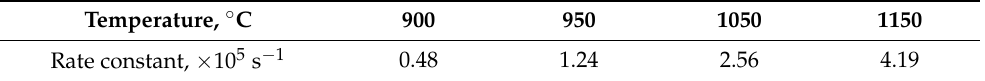
Table 2. Rate constants for the reduction of barite powder sample with brown coal.